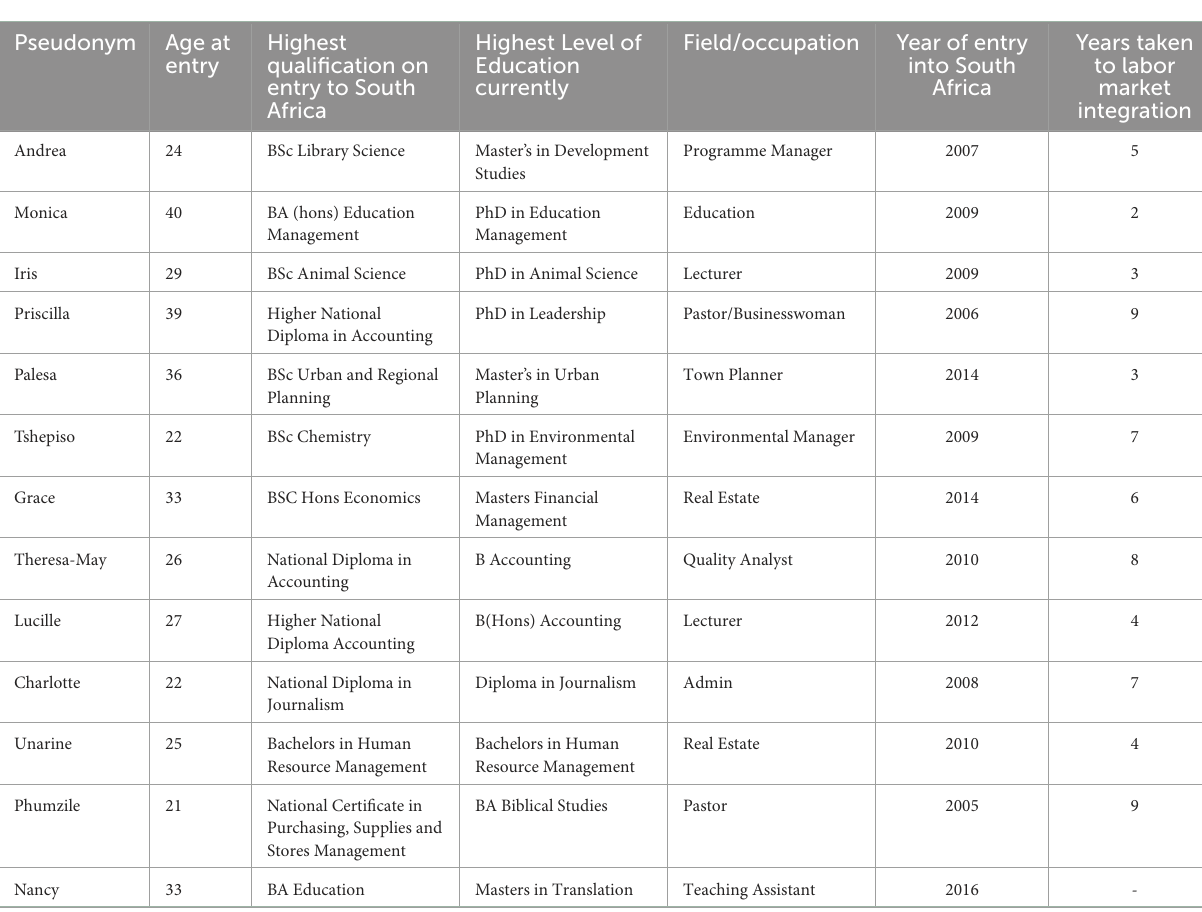
TABLE 1 Characteristics of the research